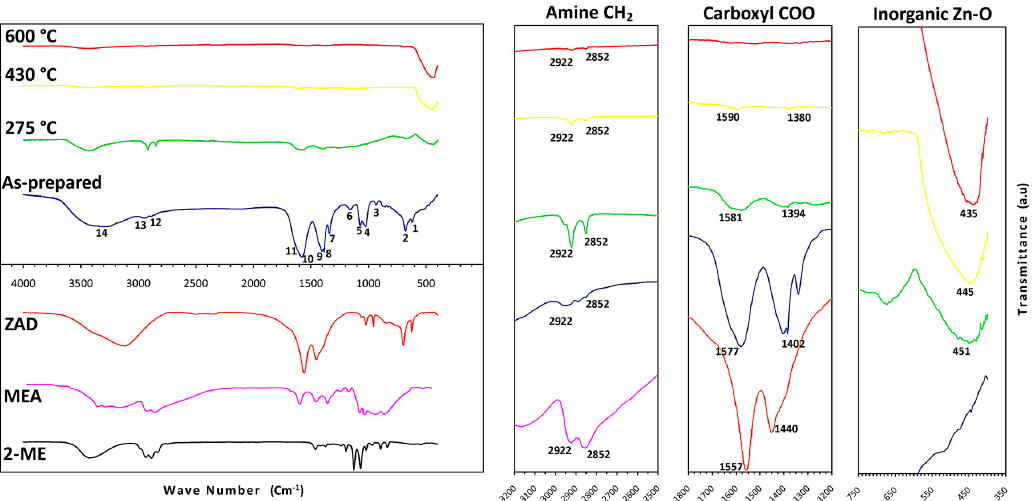
Figure 3. The IR spectra of the as-prepared aluminum-doped ZnO (AZO) gel and its thermal evolution at 275 °C, 430 °C, and 600 °C (upper left), in addition to the data of initial compounds, zinc acetate dihydrate (ZAD), monoethanolamine (MEA) and 2-methoxyethanol (2-ME) (lower left). The